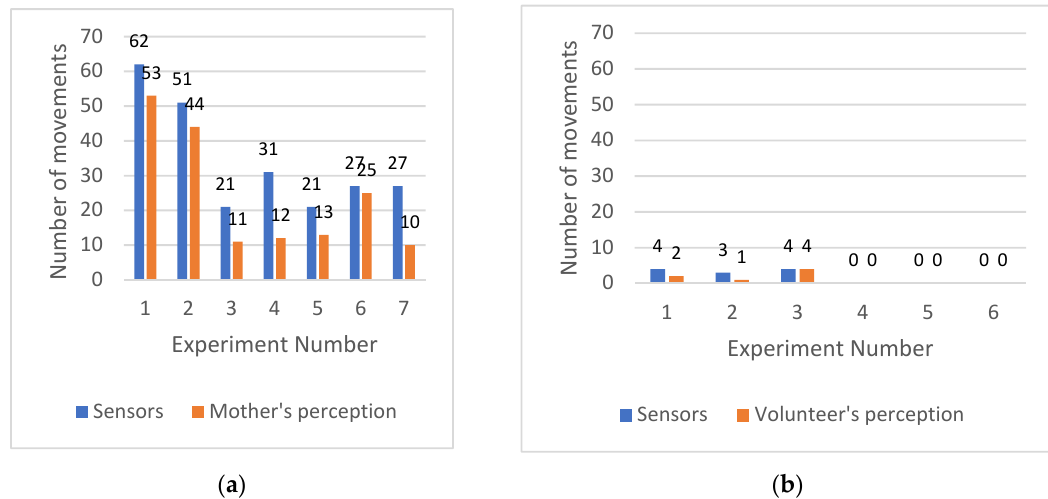
Figure 12. Comparison of number of counts felt by the volunteer and those sensed by the sensors. ( a ) Examinations on pregnant mothers. ( b ) Examinations on non ‐ pregnant women.